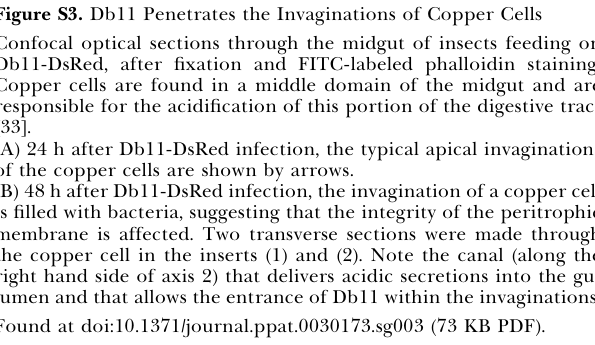
8 C for two 30-min periods) die at the same rate after a Db11 challenge (septic injury). (B) Wild-type flies that overexpress a UAS-Diptericin transgene in the midgut under the control of the NP3084 driver are somewhat more resistant to S. marcescens intestinal infections. Found at doi:10.1371/journal.ppat.0030173.sg001 (21 KB PDF). Figure S2. Death Rate of Infected Flies Varies with the Bacterial Load and Temperature Wild-type (wt) and key flies were continuously fed on different concentrations of Db11 (OD ¼ 0.1 or 0.5) at 29 8 C, and survival was monitored daily and expressed in % of surviving flies. At 29 8 C, wt and key flies die, respectively, 2 d and 1 d earlier than at 25 8 C. Flies fed on higher concentrations of bacteria succumb earlier to the infection. Found at doi:10.1371/journal.ppat.0030173.sg002 (19 KB PDF). Figure S3. Db11 Penetrates the Invaginations of Copper Cells Confocal optical sections through the midgut of insects feeding on Db11-DsRed, after fixation and FITC-labeled phalloidin staining. Copper cells are found in a middle domain of the midgut and are responsible for the acidification of this portion of the digestive tract [33]. (A) 24 h after Db11-DsRed infection, the typical apical invaginations of the copper cells are shown by arrows. (B) 48 h after Db11-DsRed infection, the invagination of a copper cell is filled with bacteria, suggesting that the integrity of the peritrophic membrane is affected. Two transverse sections were made through the copper cell in the inserts (1) and (2). Note the canal (along the right hand side of axis 2) that delivers acidic secretions into the gut lumen and that allows the entrance of Db11 within the invaginations. Found at doi:10.1371/journal.ppat.0030173.sg003 (73 KB PDF). Figure S4. Bacteria That Have Escaped from the Midgut Colonize Muscle and Tracheal Tissues The left-hand panel displays a DIC picture of the surface of the intestine; the central panel shows GFP fluorescence emitted by Db11- GFP bacteria 48 h after infection. The right-hand panel shows the superposition of both pictures. Bacteria are found mostly in the intestinal radial muscles (arrow) and in tracheoles (arrowheads). Found at doi:10.1371/journal.ppat.0030173.sg004 (134 KB PDF). Figure S5. Bacteria Can Be Seen Passing through and Inside Gut Cells after 48 h of Infection with Db11-DsRed at Higher Concentration (OD ¼ 0.5) Confocal optical sections through the cardia (A, B, D) or the anterior midgut (C) of insects feeding on Db11-DsRed, after fixation and FITC-labeled phalloidin staining. (A) Bacteria are observed inside the inner lumen of the cardia, after 72 h of infection (OD ¼ 0.1). The inner lumen is the prolongation of the foregut in the digestive tract. (B–D) After 48 h of infection at higher concentration (OD ¼ 0.5), bacteria are also seen in the external lumen of the cardia ([B], inserts 1 and 2) and appear to pass through the cell layer that separates the inner lumen from the external one (D). Bacteria seem to pass through and between gut cells in the anterior midgut (C). Found at doi:10.1371/journal.ppat.0030173.sg005 (78 KB PDF). Figure S6. Db1140 Can Also Go through Gut Epithelium, but without Affecting the Integrity of the Gut Time series of tubulin-GFP-expressing flies feeding on Db1140- DsRed bacteria. Bacteria are sometimes observed within epithelial midgut cells (arrows). In addition, the structure of the gut appears to be preserved during the course of the infection. Found at doi:10.1371/journal.ppat.0030173.sg006 (27 KB PDF). Figure S7. imd Pathway Mutant Flies Are Sensitive to S. marcescens Oral Infections Mutants fly lines for genes of the imd- pathway were fed on S. marcescens Db11 (A, C) or 20C2 (B) and their survival monitored. These mutant flies succumb earlier than wild-type controls. PGRP-LC D E12 null mutants appear to be somewhat more resistant than other imd pathway mutants. While PGRP-LE mutants behave as wild-type flies to Db11 ingestion, PGRP-LE ; PGRP-LC double mutants do not display a stronger phenotype than PGRP-LC mutants. A5001 is the wild-type control strain for PGRP-LC . Found at doi:10.1371/journal.ppat.0030173.sg007 (37 KB